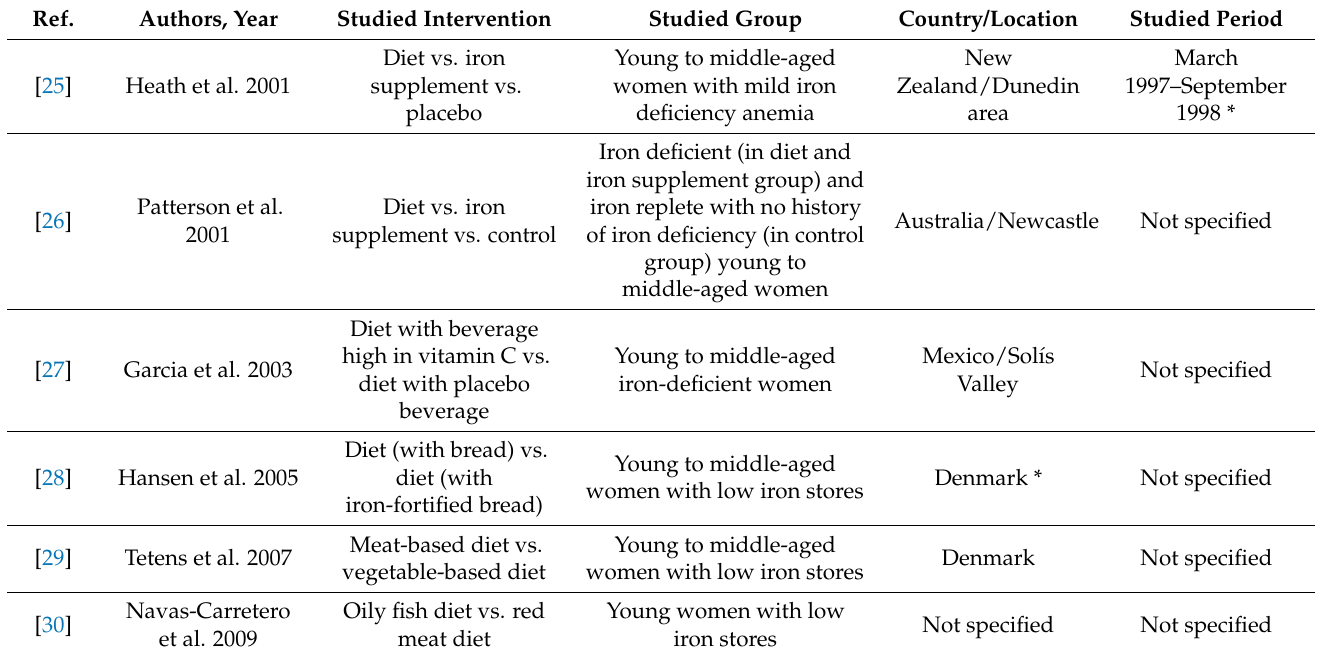
Table 3. The general characteristics of the randomized controlled trials included in the systematic